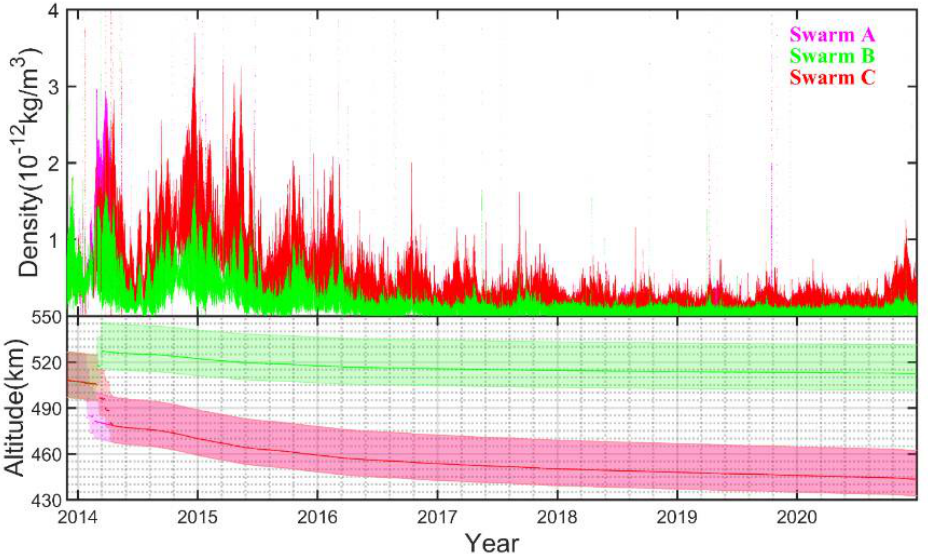
Figure 1. Daily mean altitudes and neutral densities of the Swarm satellites (The colors of Swarm A, Swarm B, Swarm C are pink, green and red. The densities of Swarm A and Swarm C overlap because the two satellites are flying closely together).